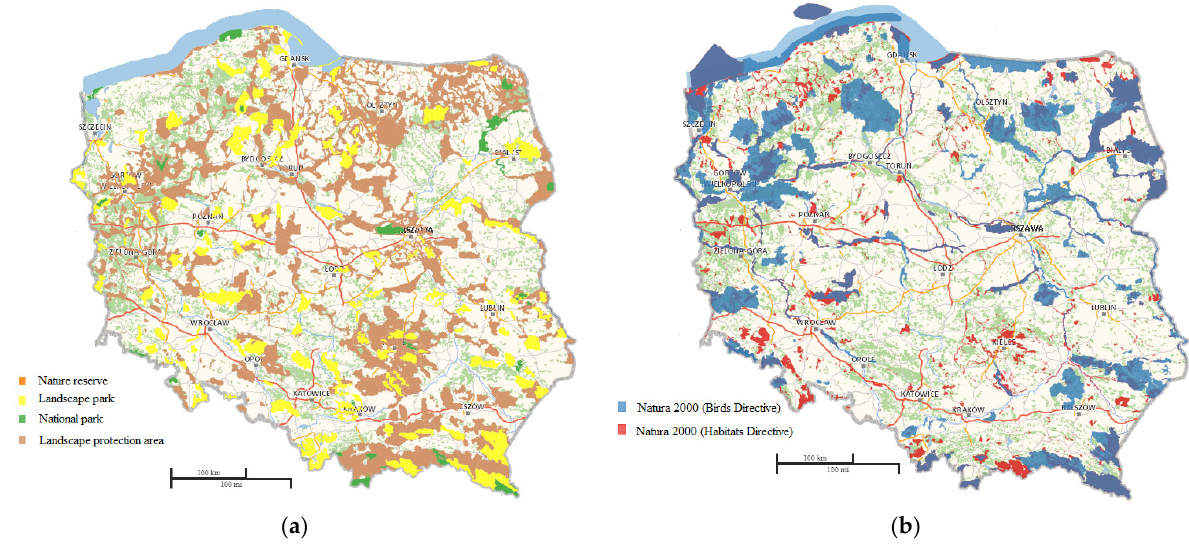
Figure 3. ( a ) Distribution of protected areas (national parks, nature reserves, landscape parks and landscape protection areas) in Poland (2021); ( b ) Distribution of Natura 2000 areas in Poland (2021) (based on [75]).